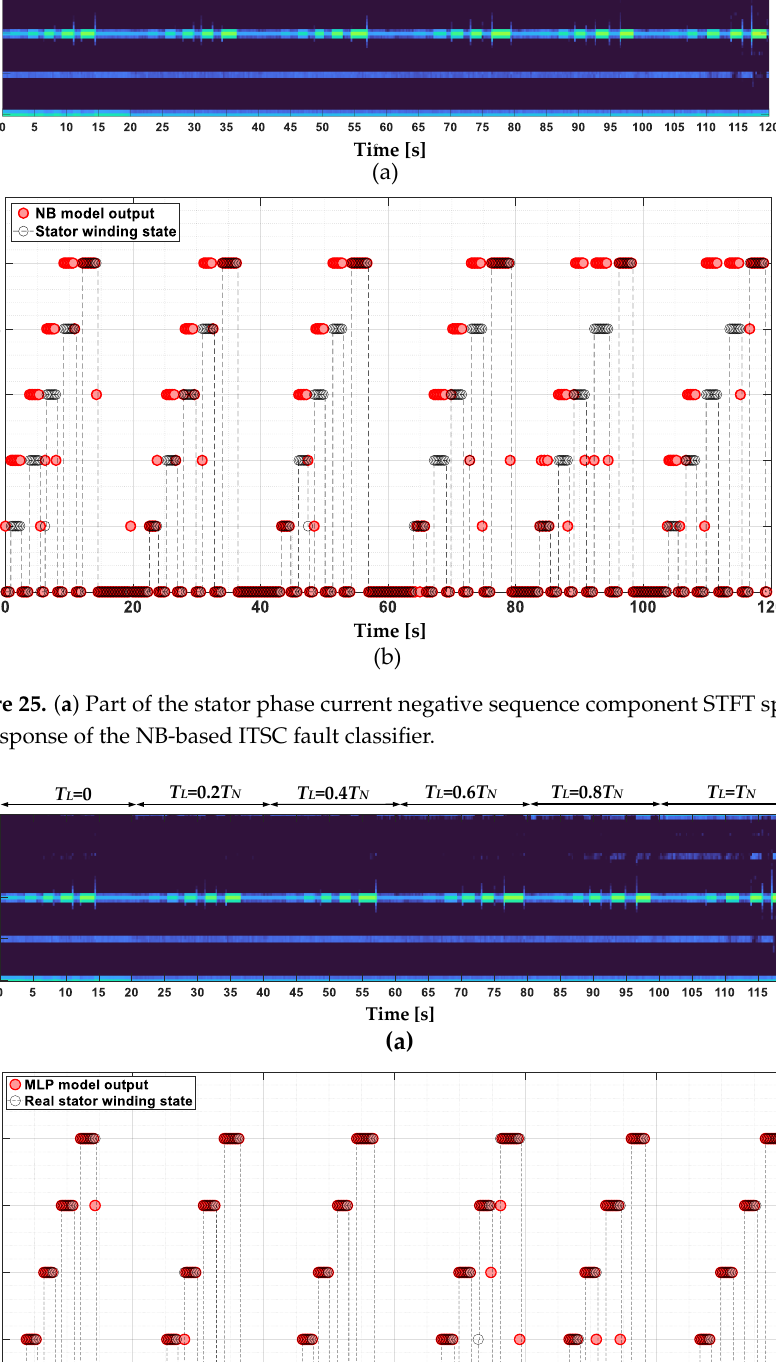
Figure 24. ( a ) Part of the stator phase current negative sequence component STFT spectrogram and ( b ) response of the SVM-based ITSC fault classifier.